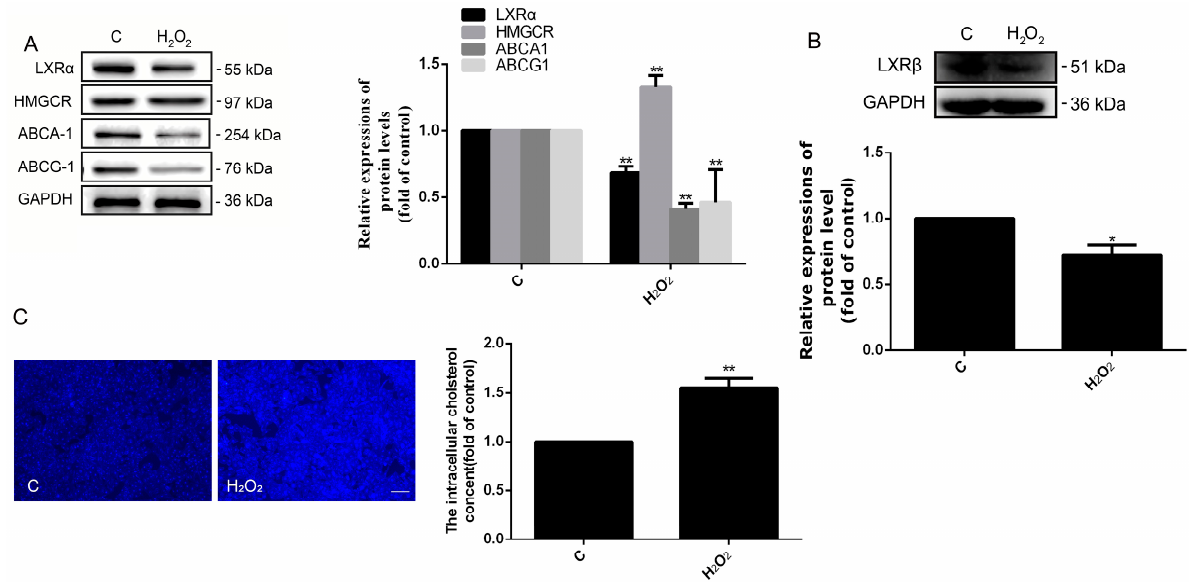
Figure 1. H 2 O 2 can promote cholesterol accumulation by oxidative stress. ( A , B ) The protein levels of LXR α , LXR β , HMGCR, ABCA1, and ABCG1 were measured by a Western blot analysis. ( C ) The accumulation of ER cholesterol after filipin staining was visualized under a fluorescence microscope (magni fi cation 5×). n = 3, * p < 0.05, and ** p < 0.001 vs. the C group (treated by PBS). C, control group; H 2 O 2 , cells treated with H 2 O 2 (500 µmol/L) for 24 h. The scale of the pictures was 100 µm.